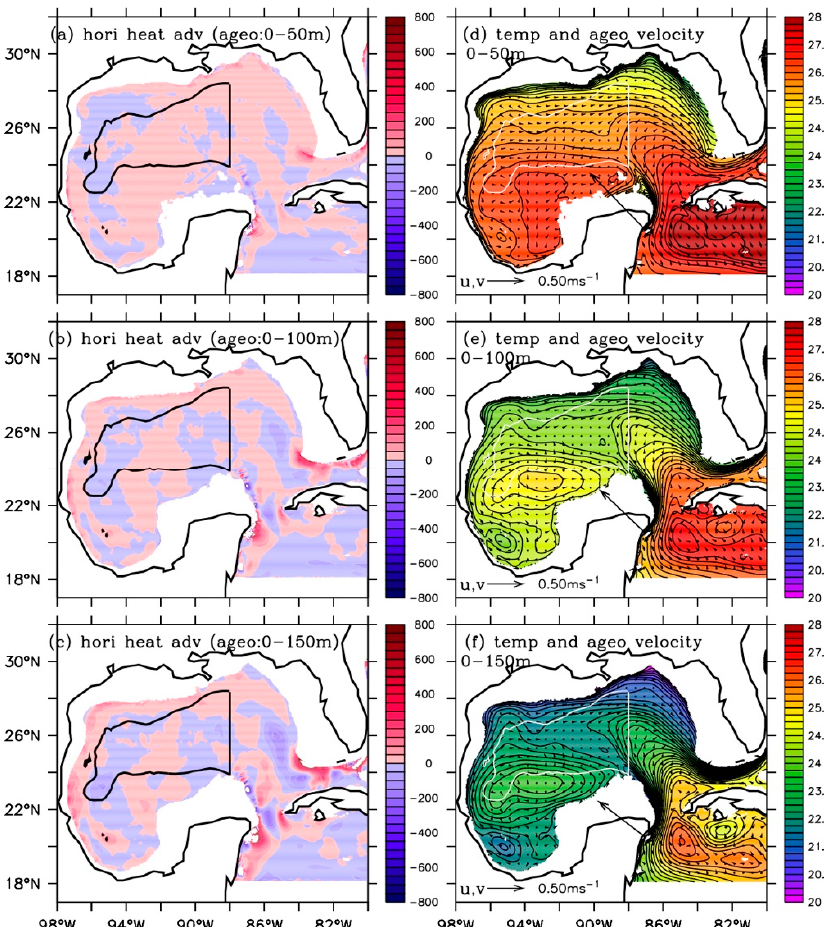
Figure 6. Mean horizontal heat advection caused by ageostrophic currents, arranged as in Figure